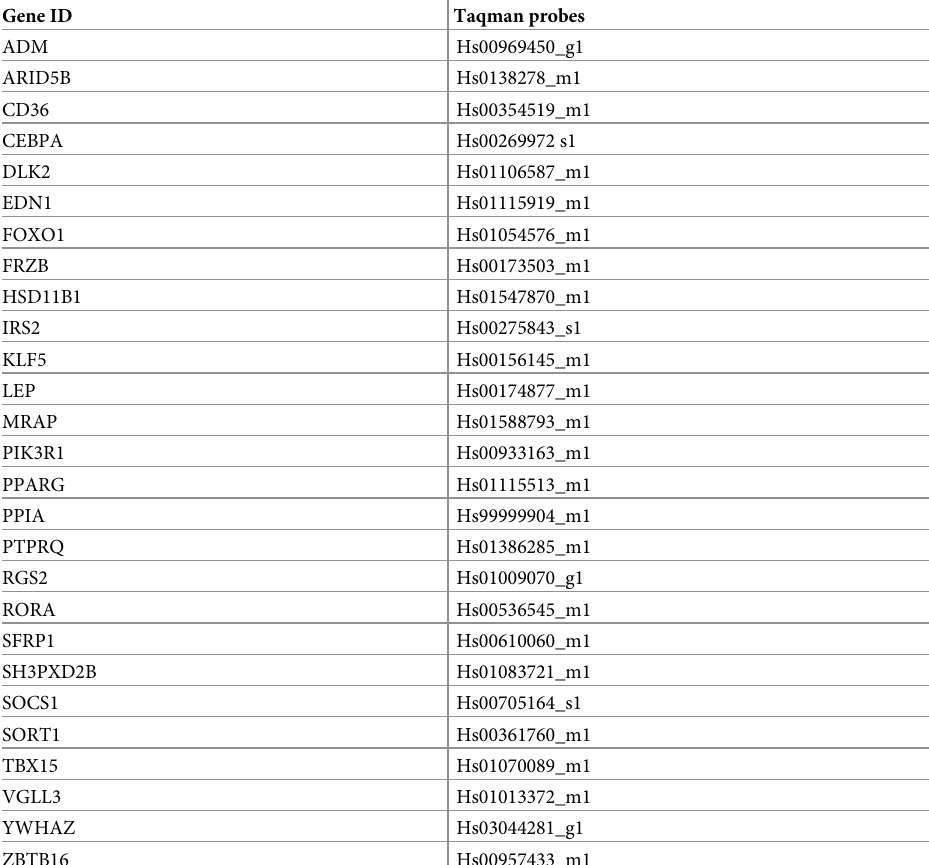
Table 2. Probes used for RT-PCR